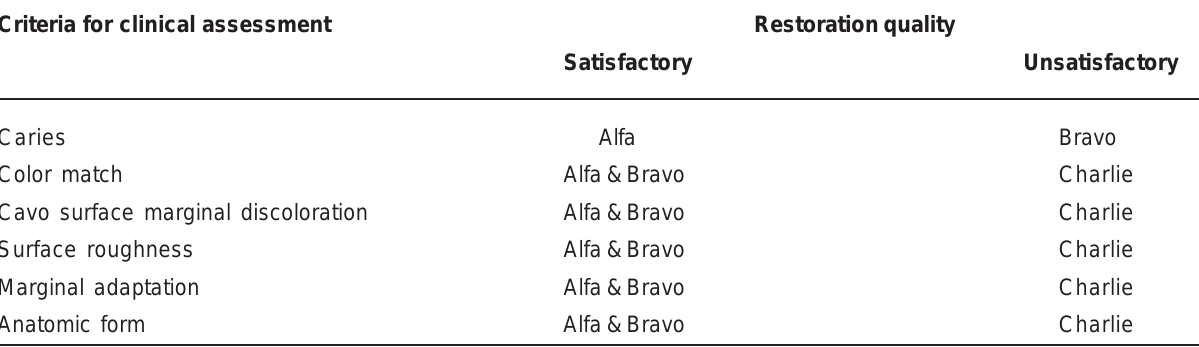
TABLE 1- USPHS criteria for composite restorations